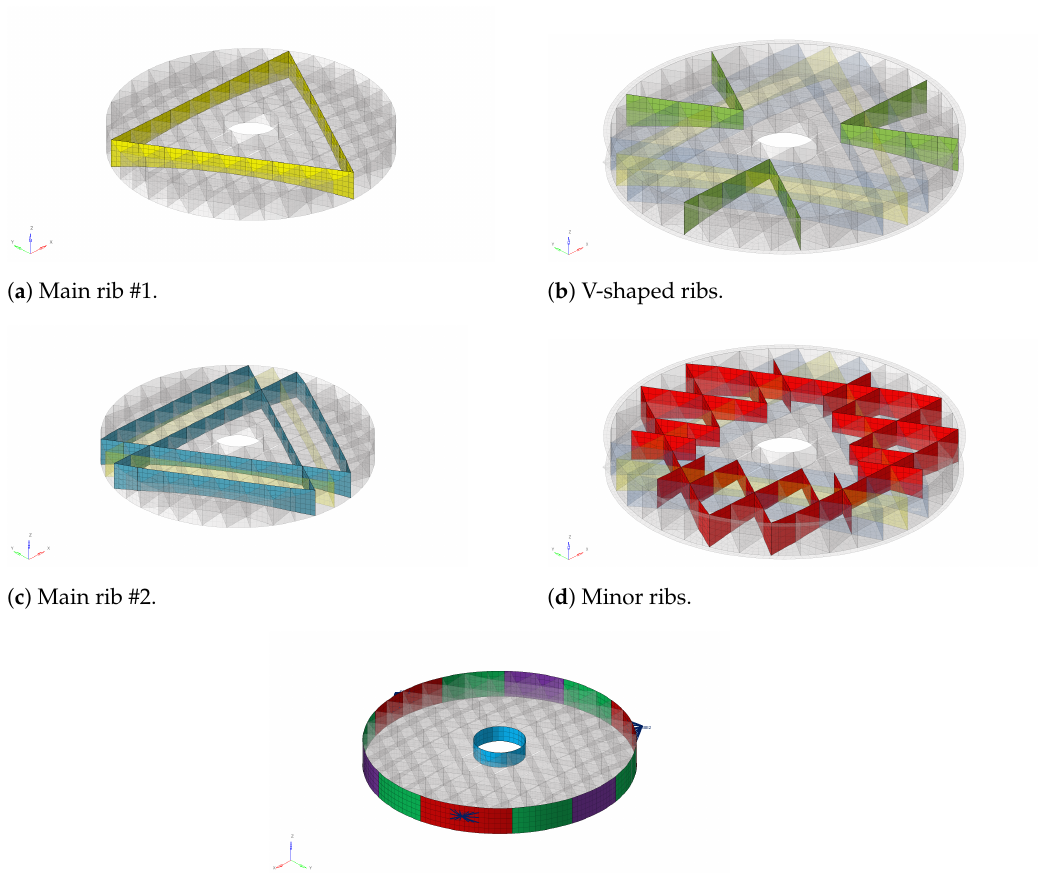
Figure 4. Identified patterns contributing to overall